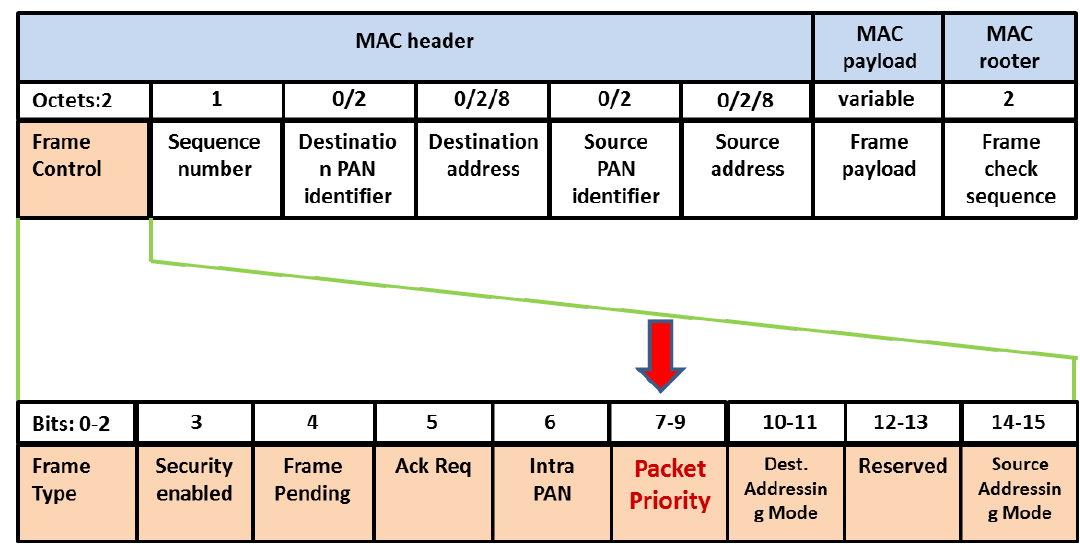
Figure 7. QoS-Aware frame control bits in IEEE 802.15.4 MAC